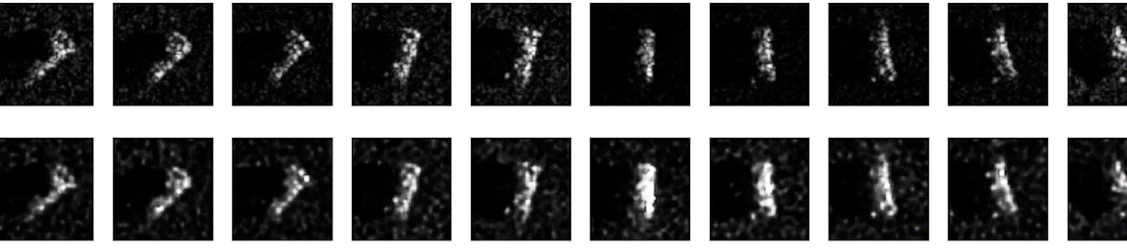
Figure 6. Original target images (up) and reconstructed target images with CAE (down).